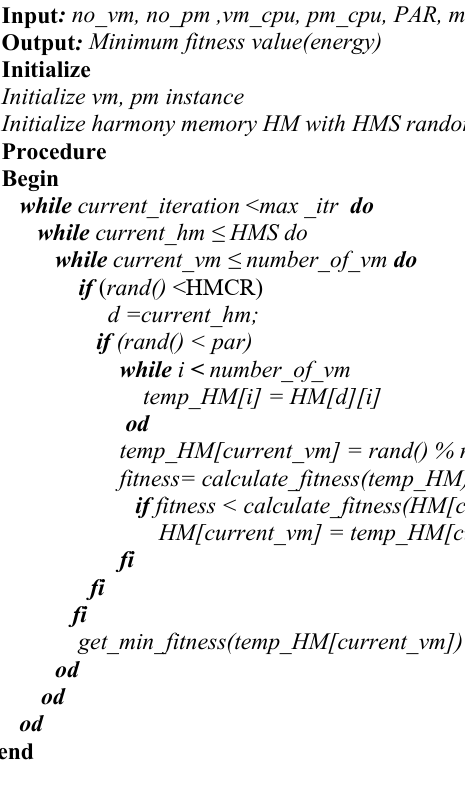
Fig. 1. Solution representation